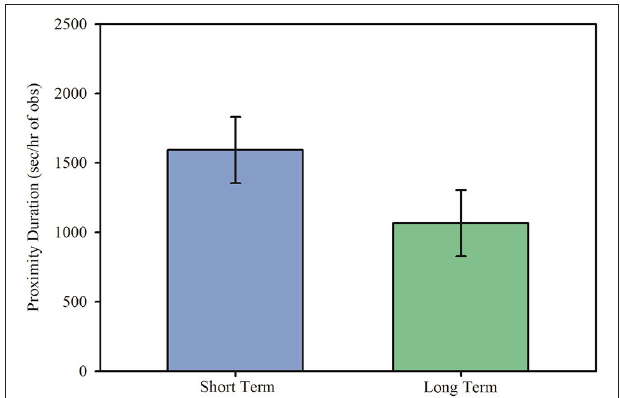
FIGURE 1 | Duration in proximity (model estimates ± SEM) to the opposite sex mate during reunion among short and long term marmoset pairs. There was no significant difference in time spent in proximity during reunion between short and long term pairs of marmosets.